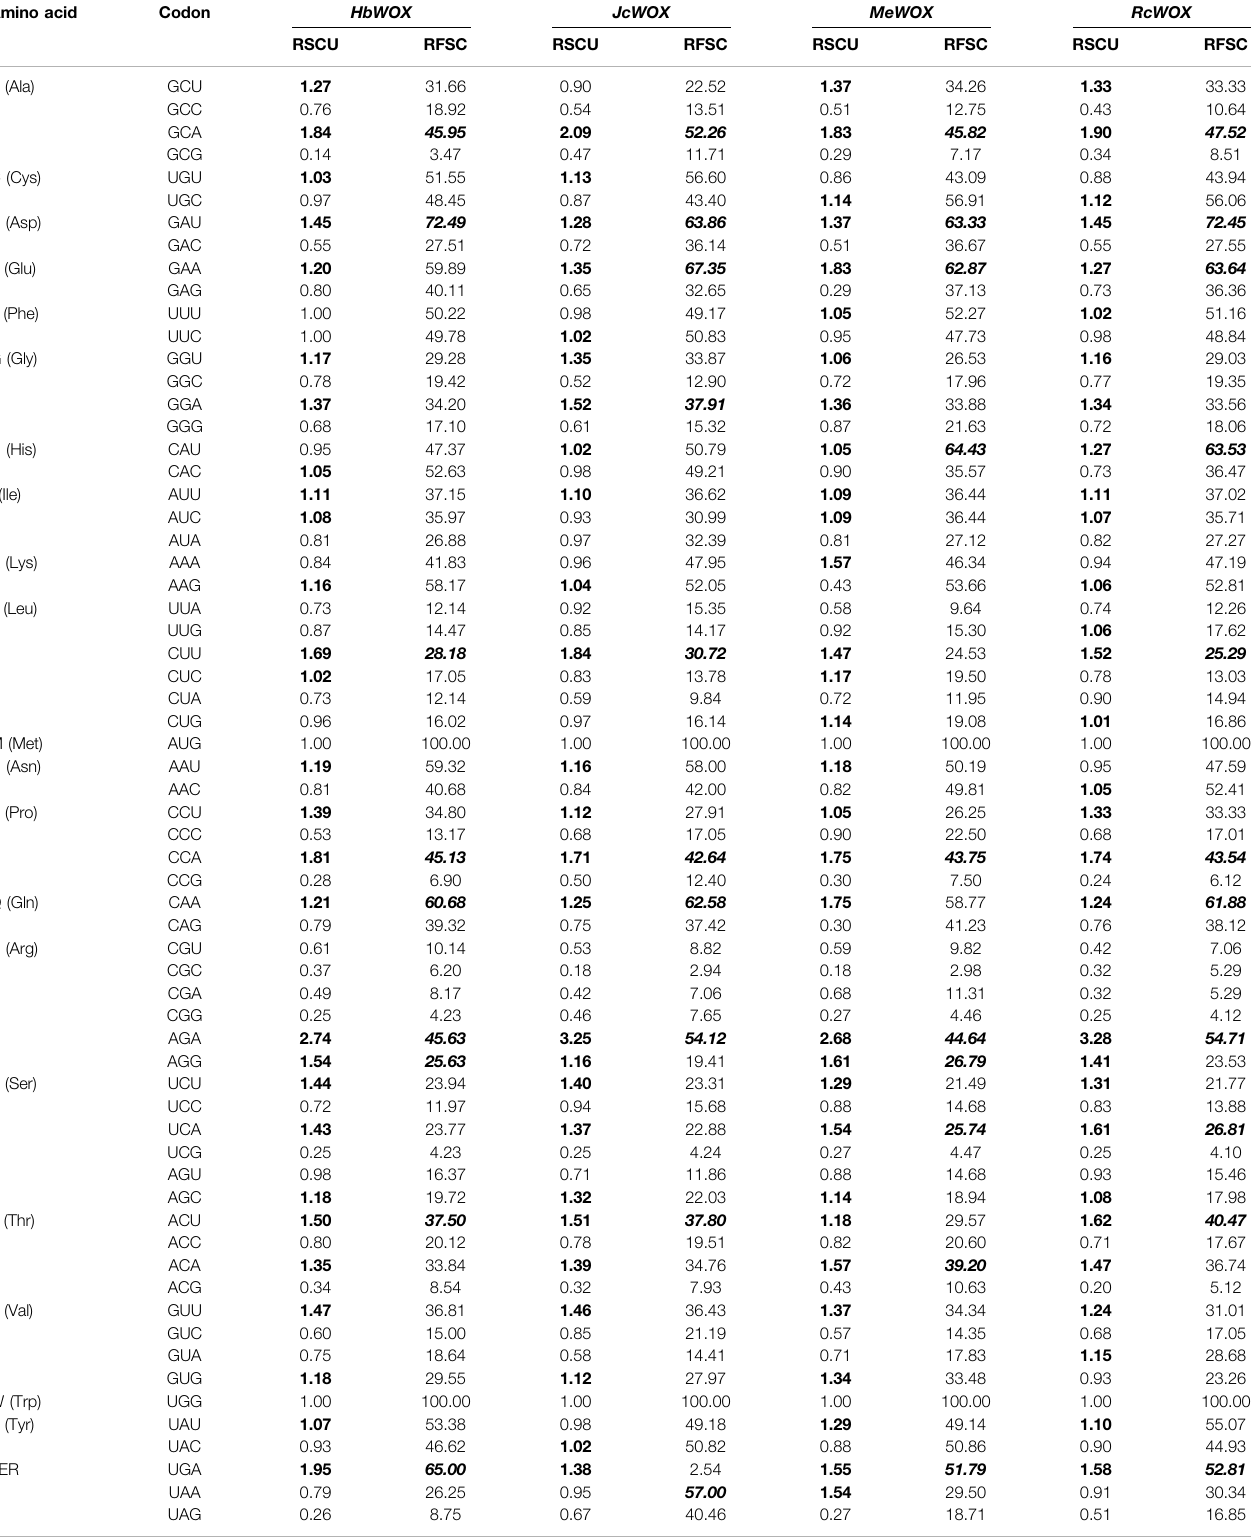
TABLE 1 | RSCU and RFSC of codons in WOX genes of four Euphorbiaceae species. Amino acid Codon HbWOX JcWOX MeWOX RcWOX RSCU A (Ala)